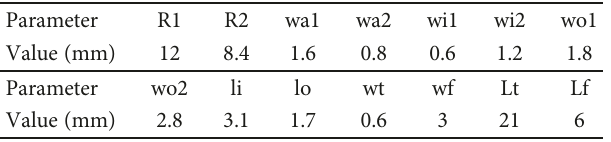
Table 1: Value of each parameter.